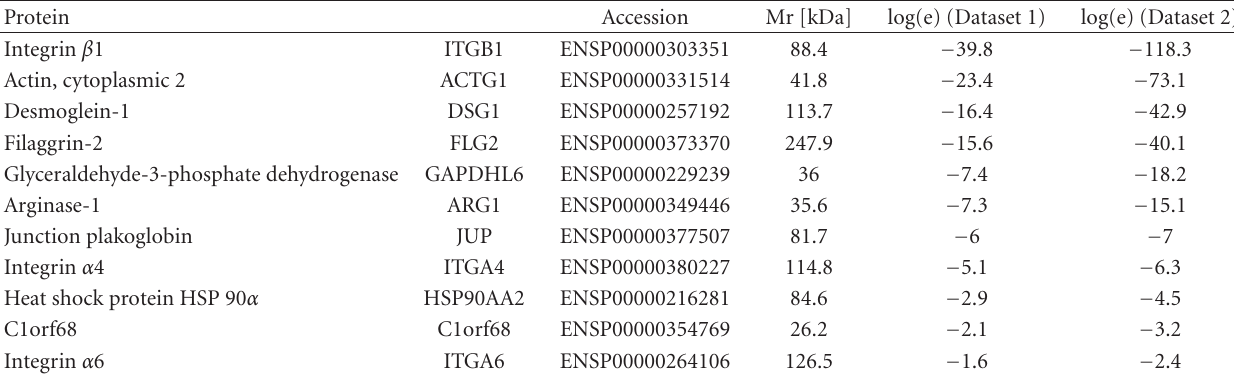
Table 2: Proteins identified in the integrin β 1 complex precipitated from Jurkat cells. Formaldehyde cross-linked Jurkat cell lysate was used to enrich integrin β 1 with JB1B. The integrin β 1 complex was identified by SDS PAGE analysis and studied by LC-MS/MS and the GPM. Only proteins with a log(e) < − 1 and which were identified in both datasets and not in control samples are